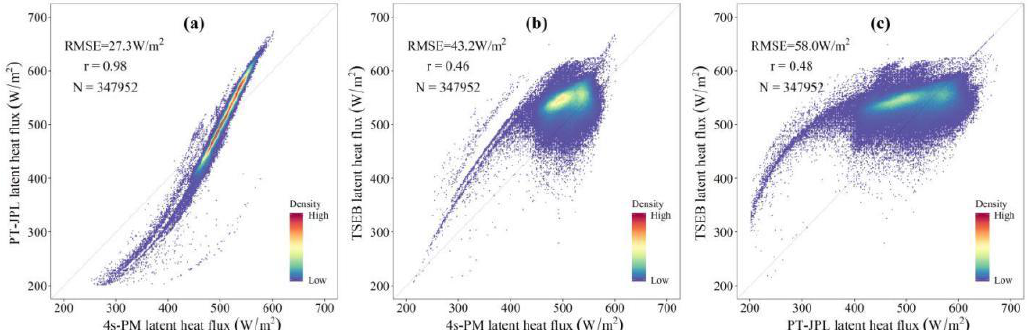
Figure 10. Density plots of comparisons of maize instantaneous latent heat flux derived from Landsat 8 for the three models (( a ) 4s-PM vs. PT-JPL, ( b ) 4s-PM vs. TSEB, ( c ) PT-JPL vs. TSEB) on 19 August of 2014. The legend refers to the frequency of data points at each location.